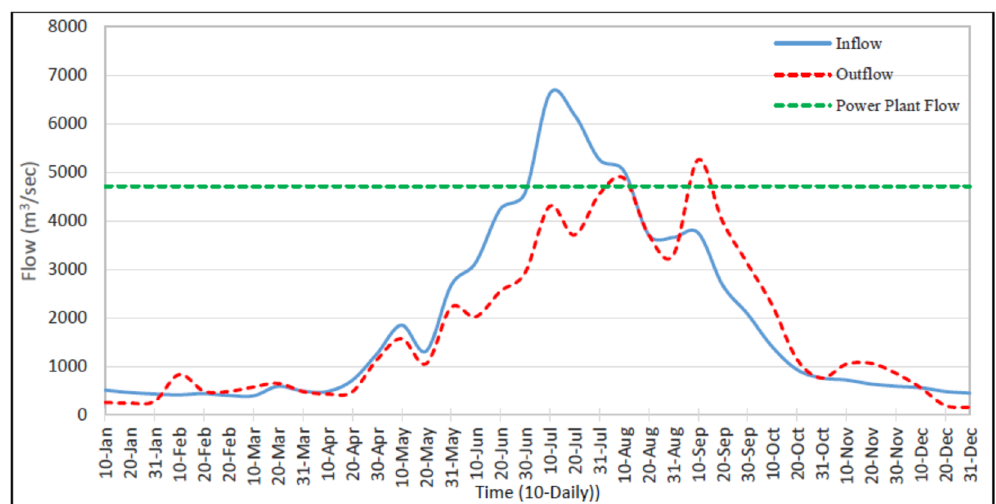
Figure 32. Inflow-Outflow Hydrographs of year 2020.